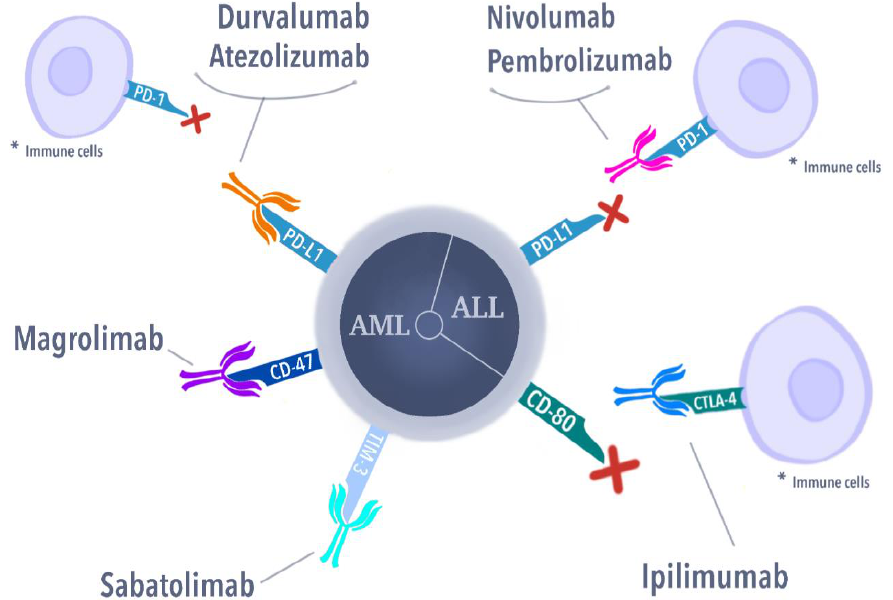
Figure 2. Immune checkpoint inhibitors are pediatric cases of acute leukemias. * Immune cells are Antigen Presenting Cells (B lymphocytes, dendritic cells, and macrophages) for PD-1+ cells. CTLA-4 is present in activated T-cells.